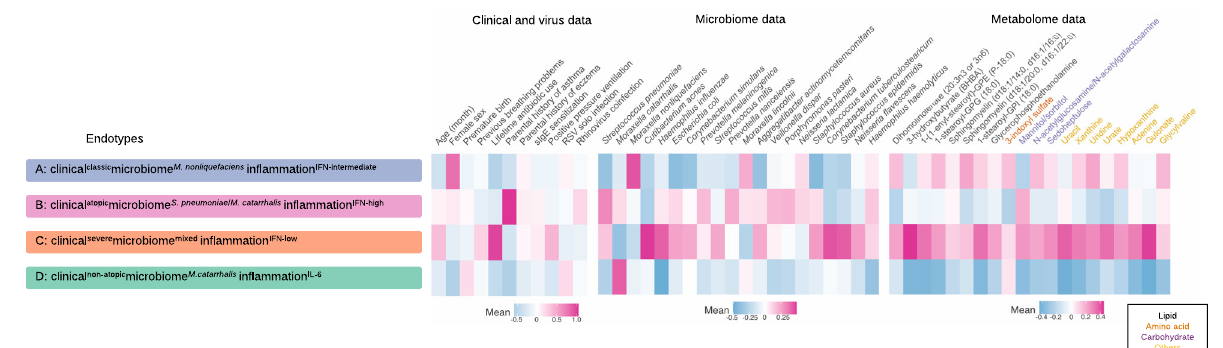
Fig. 2 Between-endotype differences in clinical variables, virus, nasopharyngeal microbiome, and nasopharyngeal metabolome data in infants with respiratory syncytial virus bronchiolitis. To visualize the between-endotype differences, the clinical variables and viruses are treated as numeric variables and processed by autoscaling. The microbiome data (20 most abundant species) are processed by log 2 transformation and autoscaling. The metabolome data (20 metabolites with the highest normalized mutual information score) are processed by log 2 transformation with batch effect adjustment and autoscaling. RSV respiratory syncytial virus, IFN interferon, IL interleukin, sIgE speci fi c immunoglobulin